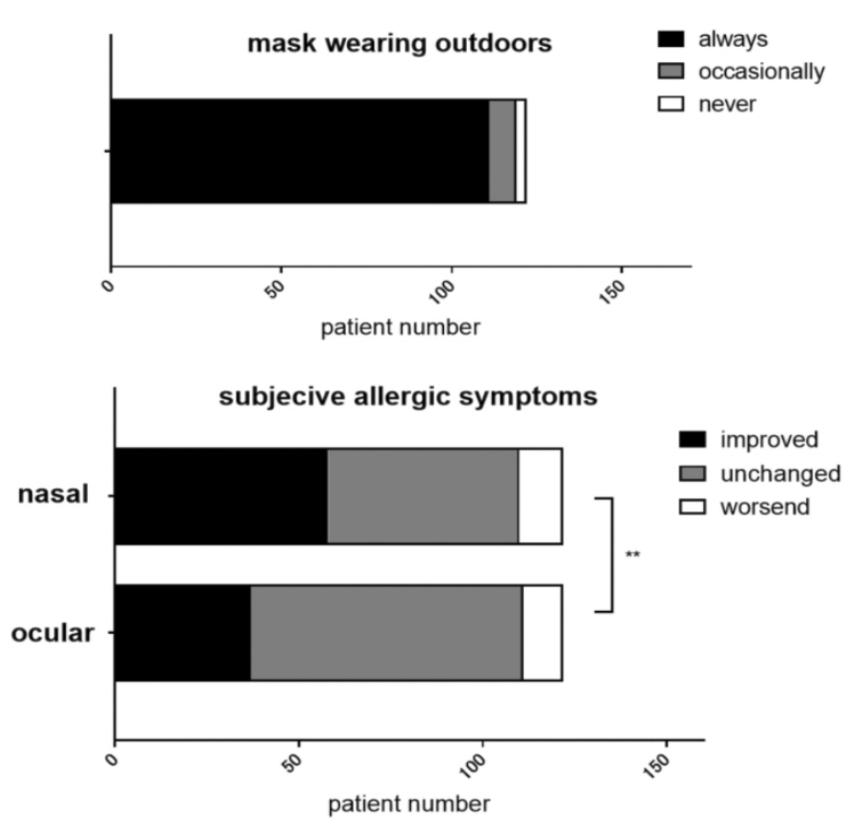
Figure 4. Changes in the social behaviors and the severity of subjective allergic symptoms after the start of the COVID-19 pandemic. Clinical records were surveyed from 122 cedar/cypress pollinosis patients who visited the hospital/clinics from April to May in 2022. ** p < 0.01, Fisher’s exact test.